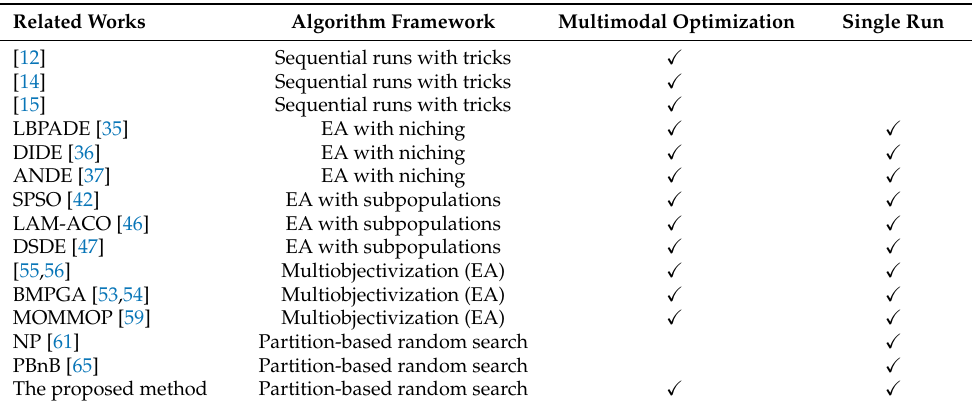
Table 1. Classification of selected related